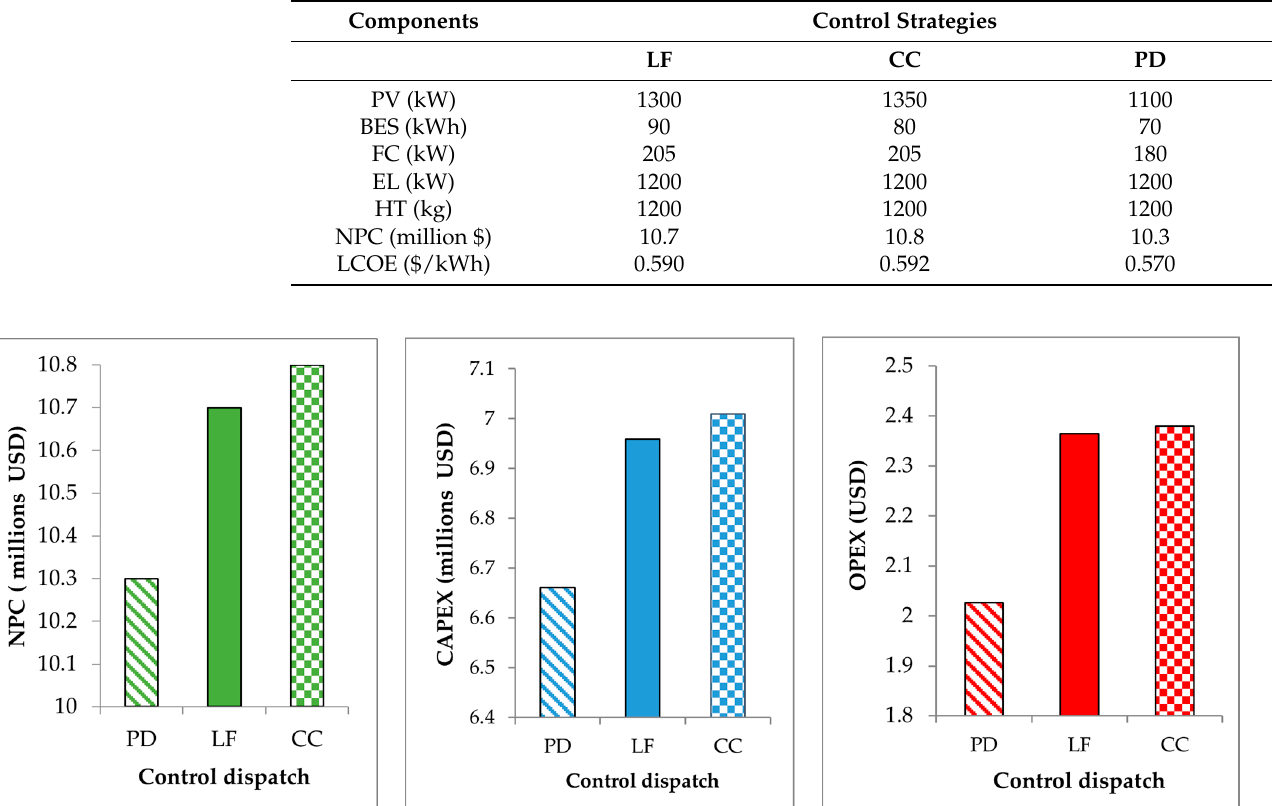
Figure 6. Net present cost, CAPEX, and OPEX for PD, LF, and CC control